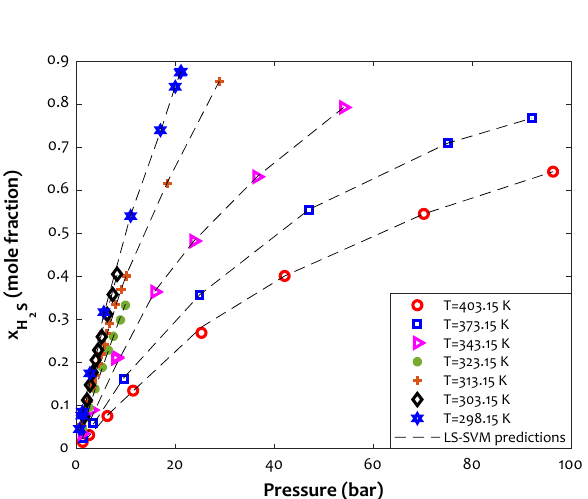
Figure 9. The effect of pressure on the H 2 S solubility in [BMIM][PF 6 ] ionic liquid in a wide range of